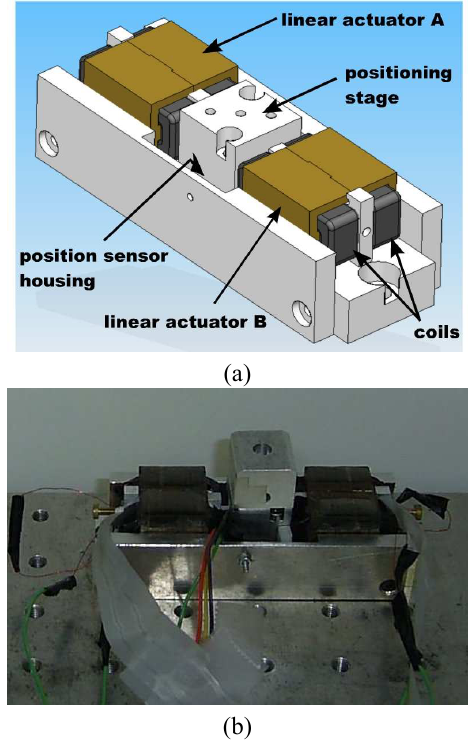
Figure 6: Push-pull actuator using two antagonist MSMA samples: (a) CAD model, (b) picture of the final